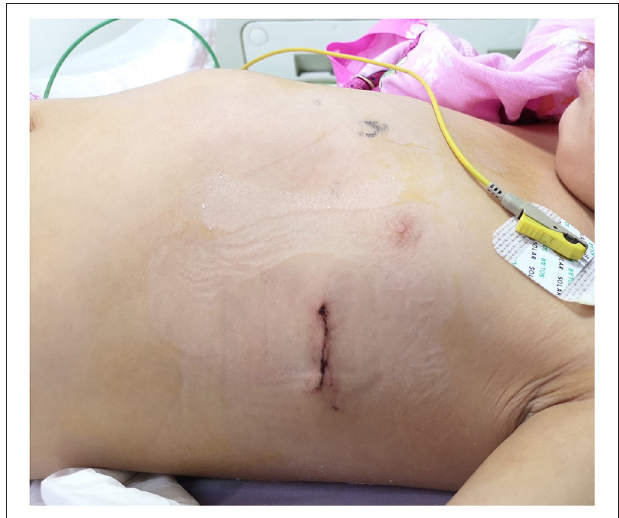
FIGURE 2 | The appearance of the left chest wall incision and the corrected chest 1 day after surgery.